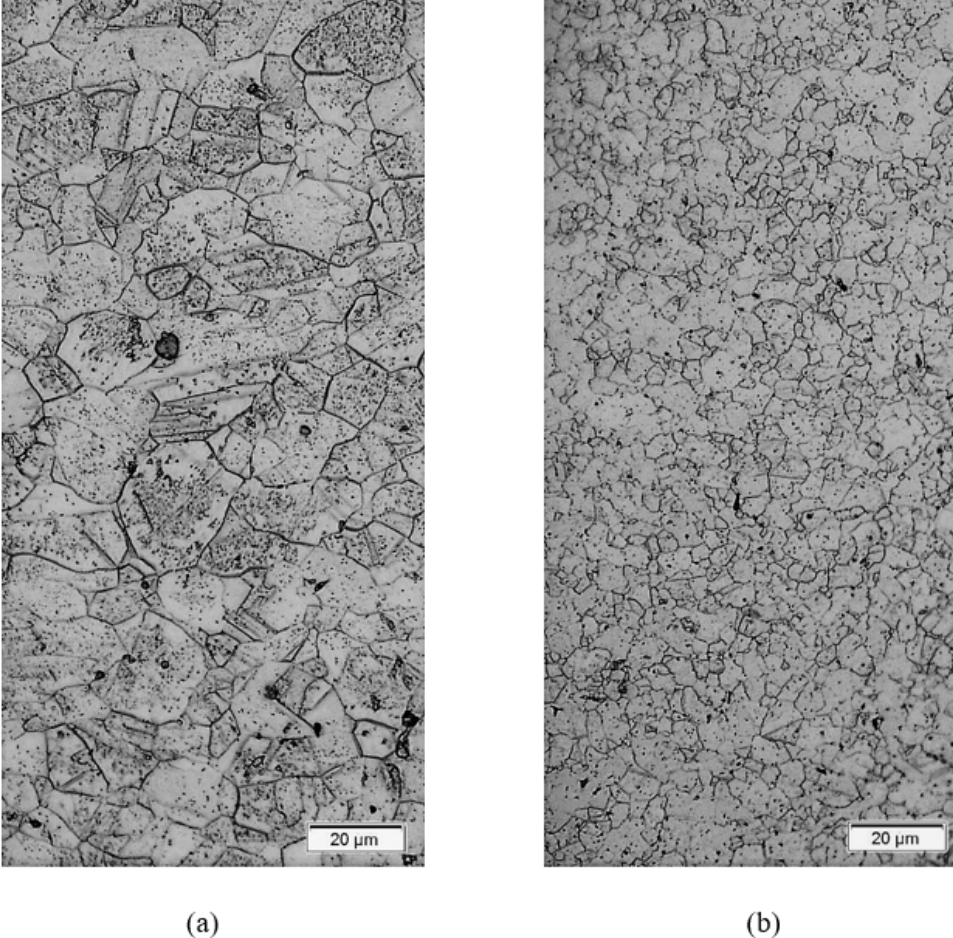
Figure 2. Optical micrographs: ( a ) parent metal ( b ) friction-stir-processed material.